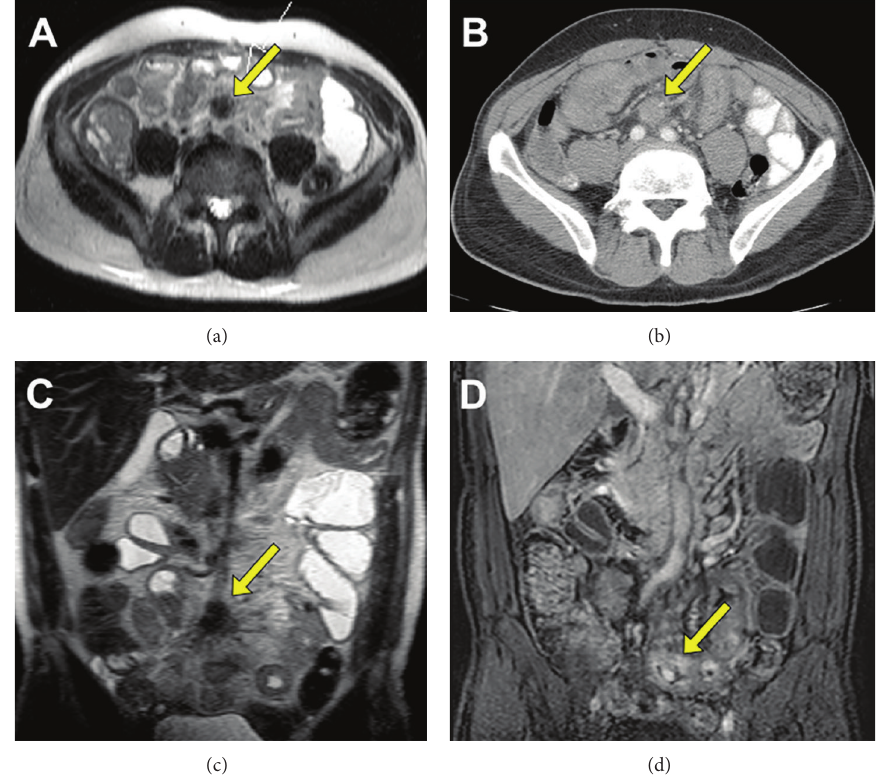
Figure 1: Axial MRE image showing mass in the small bowel mesentery and an enlarged lymph node (a) compared to an axial CT scan that only shows bowel wall thickening (b). Coronal MRE images with carcinoid tumor and an enlarged lymph node in the mesentery (c) and mass in the bowel wall (d).